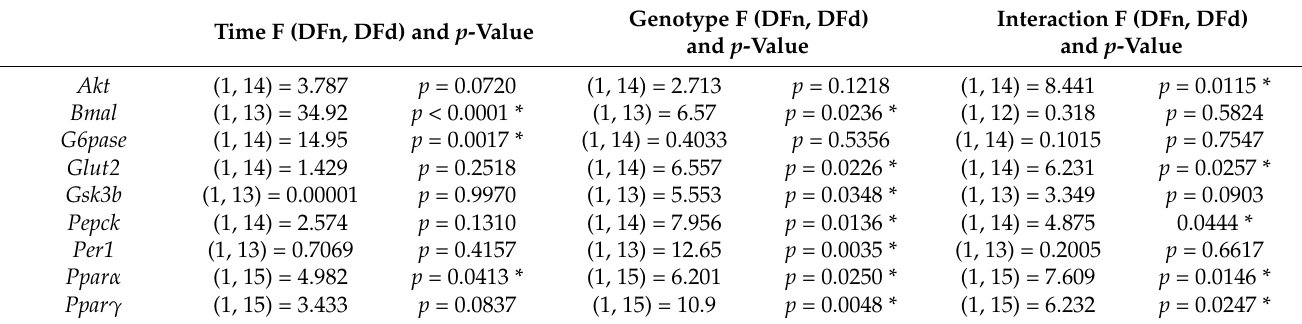
Table 1. ANOVA parameters related to gene expression in the